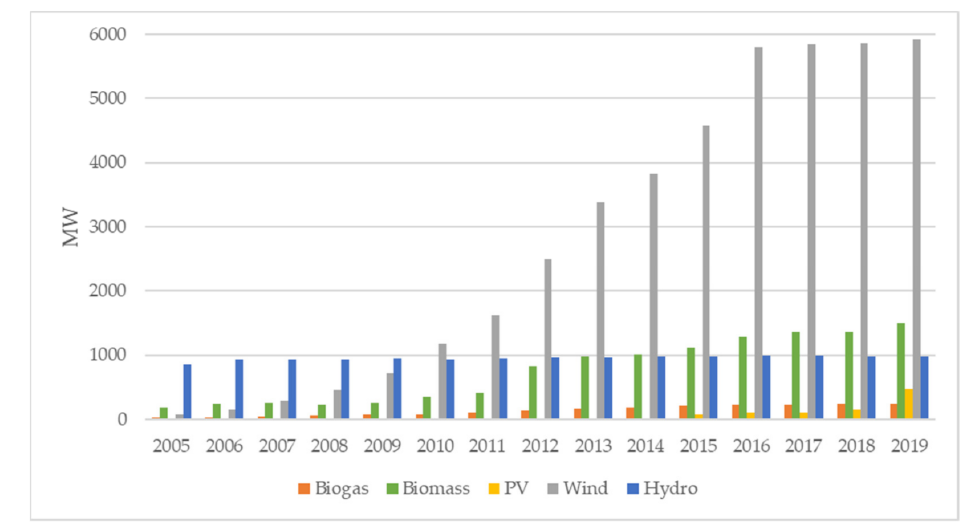
Figure 2. Renewable energy capacity installed in Poland in 2005–2019 [MW]. Source: developed by the authors, based on Reference